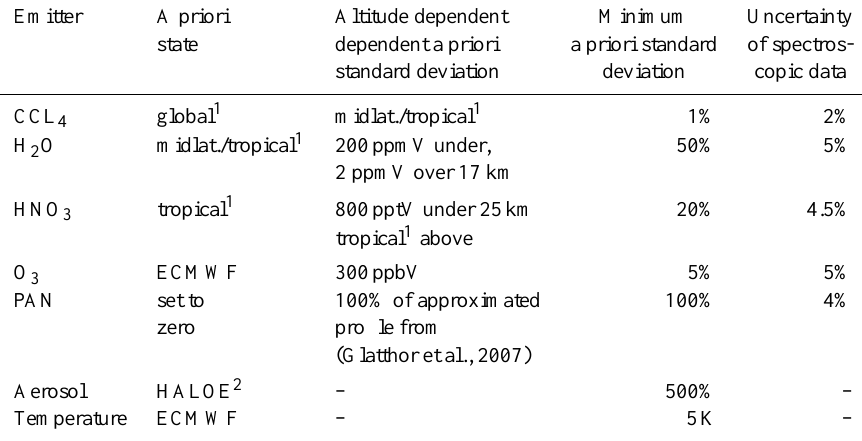
Table 3. Retrieved gases, aerosol and temperature.